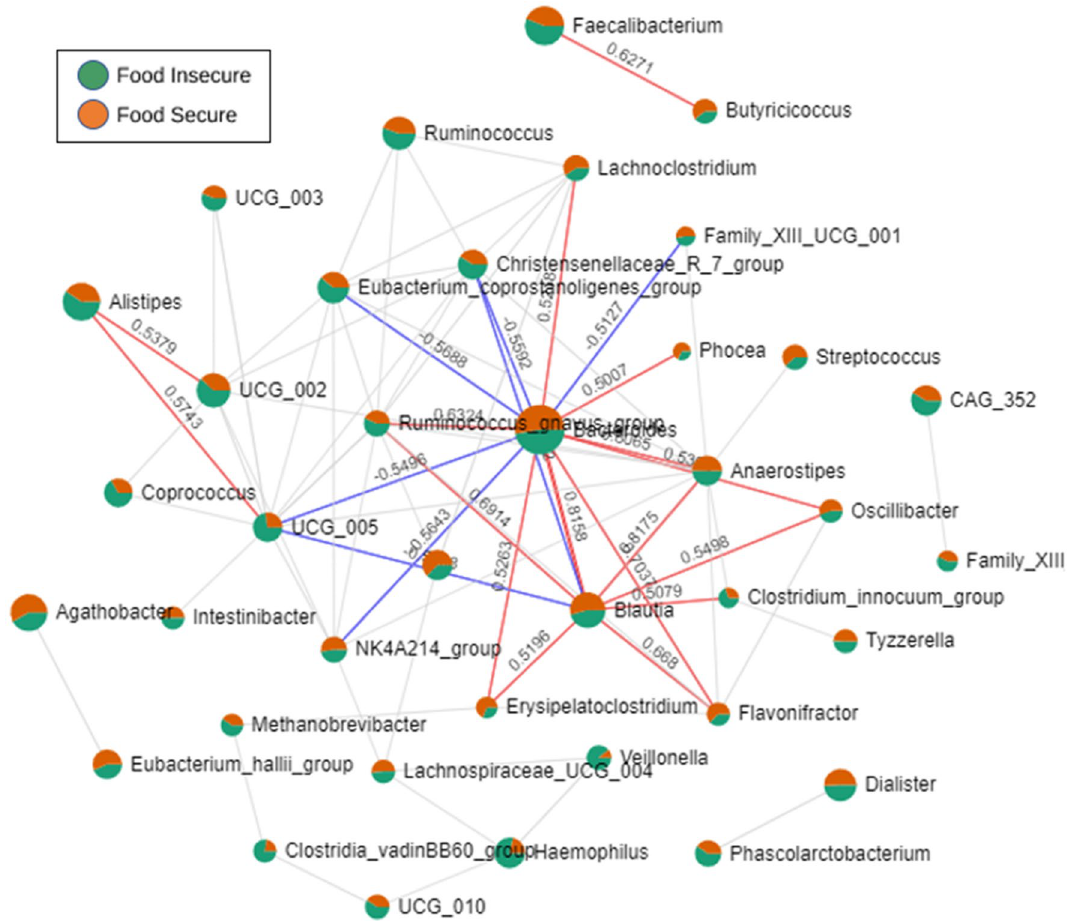
Figure 4. Correlation analysis of taxa at the genus level between food insecurity and food security status. Network analysis between abundant taxa constructed from SparCC correlation coefficients (| R 2 | > 0.5, p < 0.01). Note, each node represents a microbe by abundance between food security status, with the lines (and corresponding values) indicating the correlation coefficients between the genera. Blue edges are negative correlations and red edges mean positive correlations.